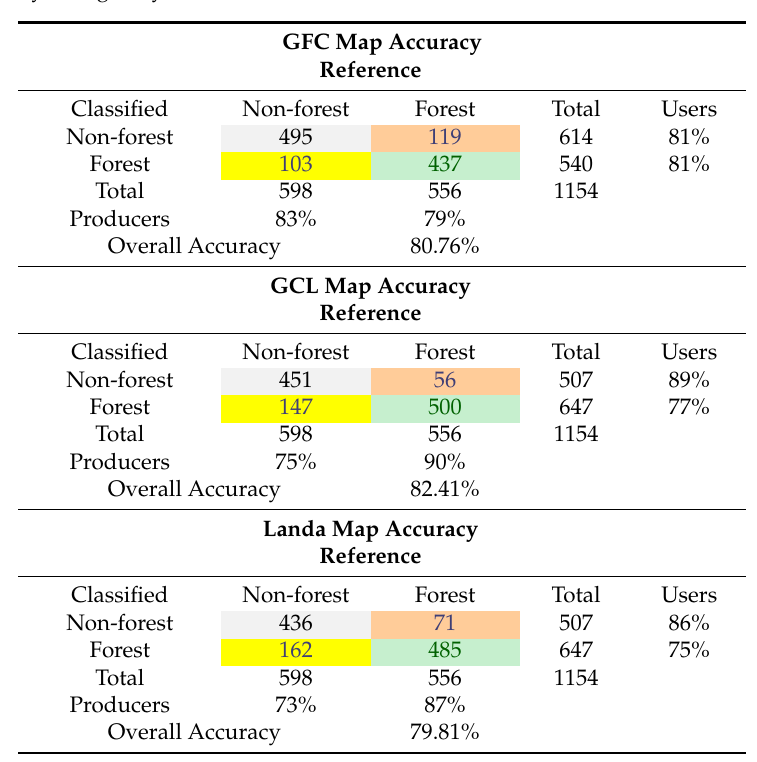
Table 3. Confusion matrices for each of the forest / non-forest products. Shown here is the overall percentage of reference points classified correctly (Overall accuracy), the per-class errors of omission (Producer’s accuracy), and the per-class errors of commission (User’s accuracy). The colors correspond to the point colors in Figures 4–6. See Table A2 and the text for area-corrected accuracy estimates; overall accuracy changed by < 0.3% before and after